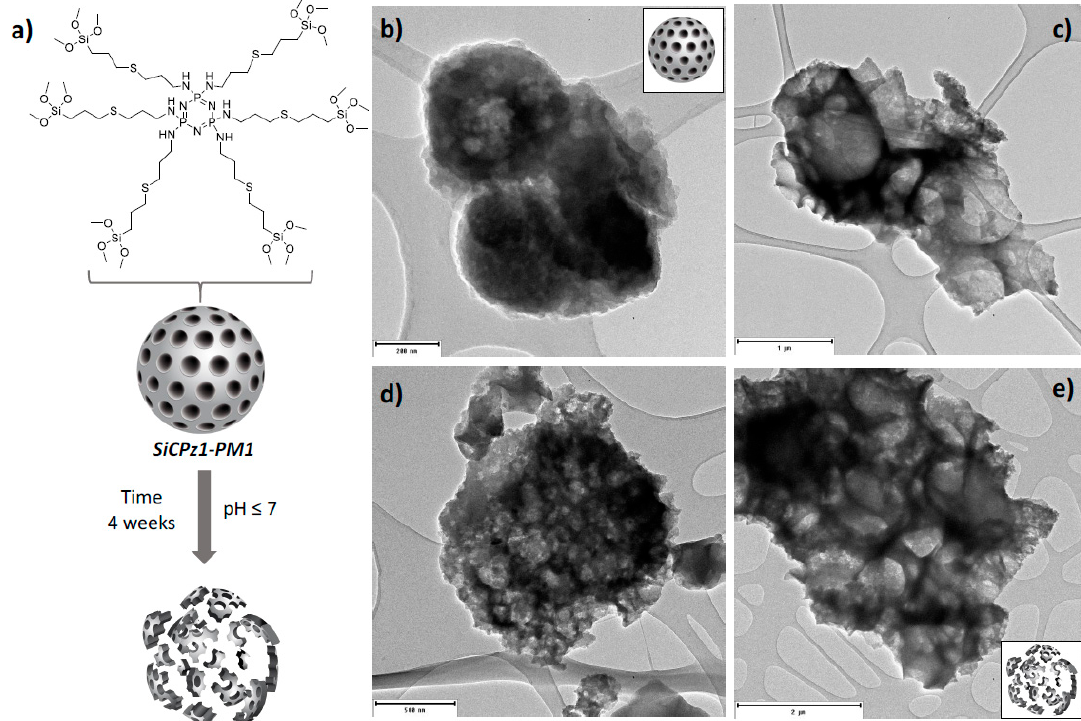
Figure 5. Illustration of the SiCPz1-PM1 degradation ( a ) and TEM images of the SiCPz1-PM1 in an aqueous solution at neutral pH 7 for 1 ( b ) and 4 weeks ( c ) and at acidic pH 2 for 1 ( d ) and 4 weeks ( e ). Scales: 200, 500, 1000, and 2000 nm.